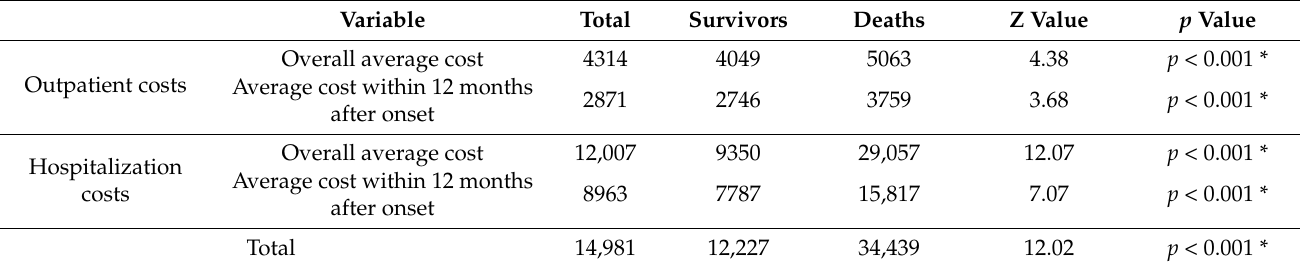
Table 4. Analysis of direct economic burden of cervical cancer